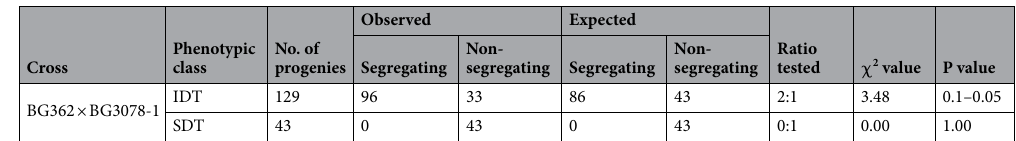
No. of progenies